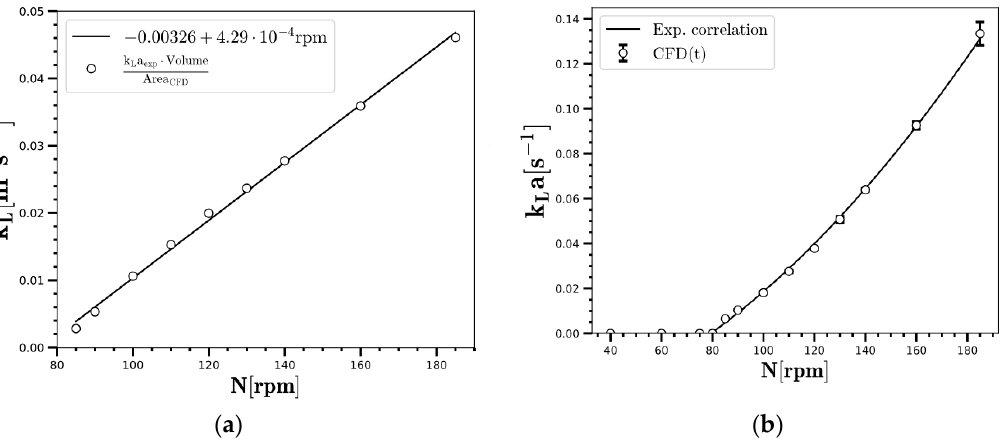
Figure 11. Estimation of the liquid mass transfer coefficient ( 𝑘 (cid:3013) ) as a function of the rotational speed ( a ) and comparison of 𝑘 (cid:3013) 𝑎 values from the correlation using experiments ( b ) with CFD.